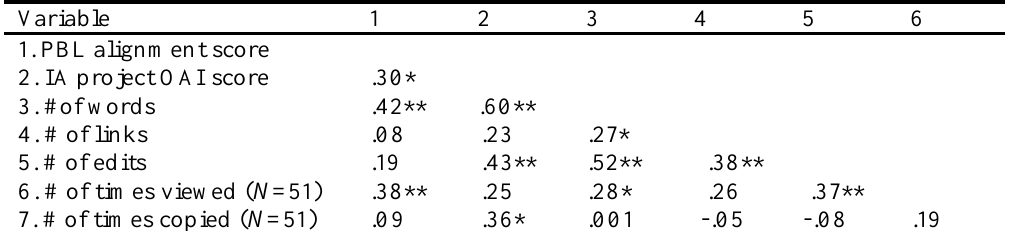
Spearman’s Rank Correlations between PBL Alignment Score, OAI Score, and IA Project Features for IA Projects Created by PD Participants